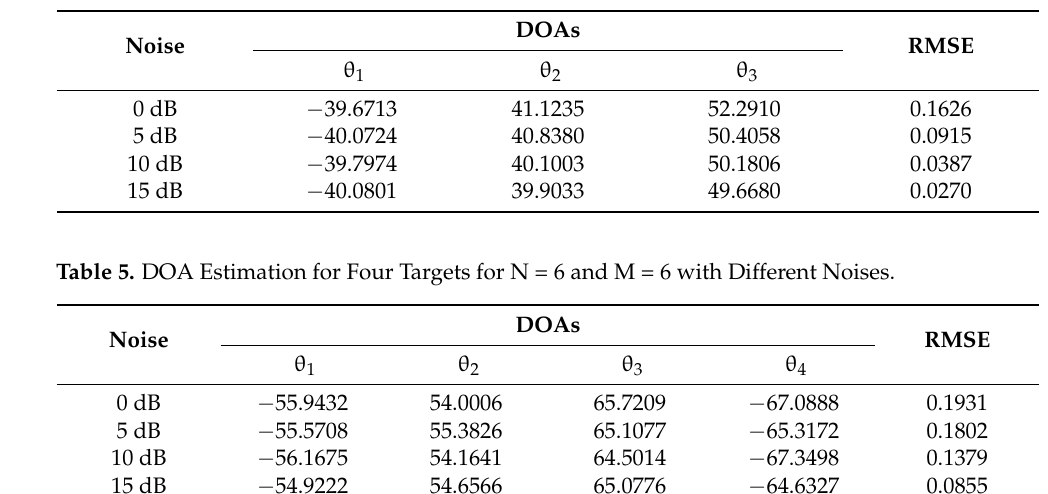
Table 4. DOA Estimation for Three Targets for N = 6 and M = 6 with Different Noises.